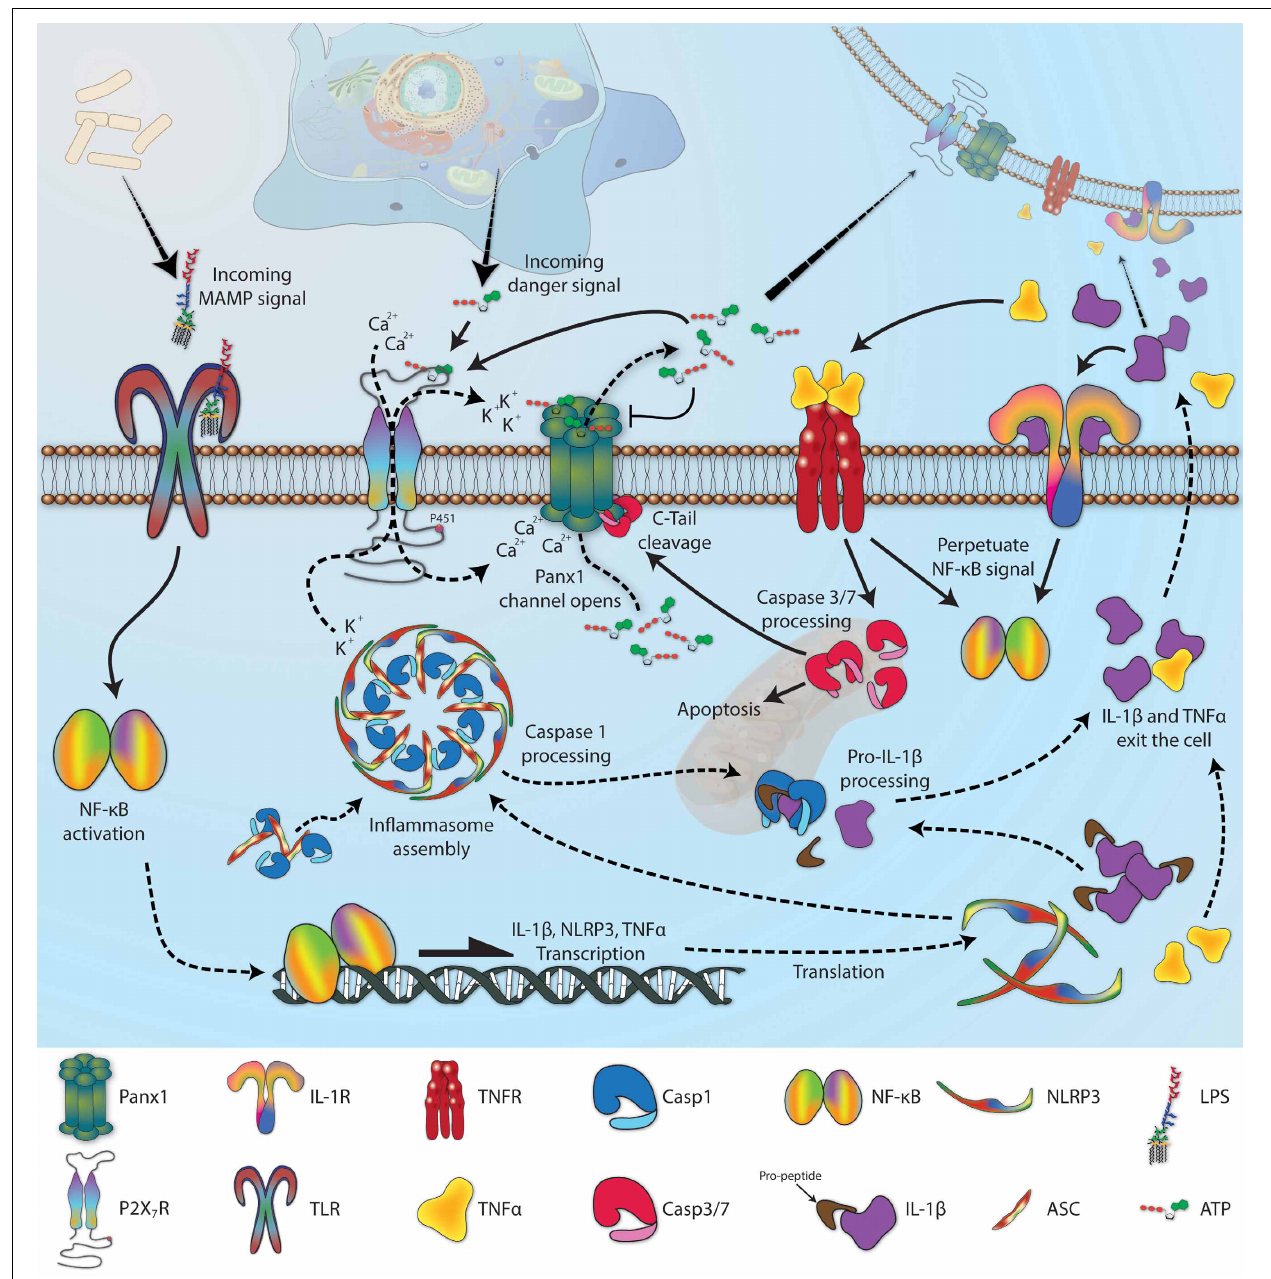
FIGURE 2 | The role of Panx1 in induced innate immunity. When an invading microbe breaches an epithelial barrier, microbe-associated molecular patterns (MAMPs) are recognized by phagocytic cells [e.g., lipopolysaccharide (LPS) binding to toll-like receptors (TLR)], leading to an activation of the NF- κ B signaling cascade which up-regulates expression of the inflammasome component NLRP3, pro-IL-1 β , and TNF α . Inflammasome assembly brings NLRP3 and pro-caspase1 together, using the adaptor protein ASC, and the whole complex associates with P2X 7 R. If extracellular ATP levels become elevated because of cellular distress in the vicinity (i.e., a “danger signal”), P2X 7 R activation allows calcium to flow into the cell and potassium to flow out-of the cell, along their respective concentration gradients. Lower intracellular potassium is correlated with inflammasome activation, leading to processing of pro-caspase1 into its active state. Panx1 is held in close proximity to P2X 7 R because of an interaction with residue P451 on the C-terminal end of the receptor, allowing local increases in extracellular